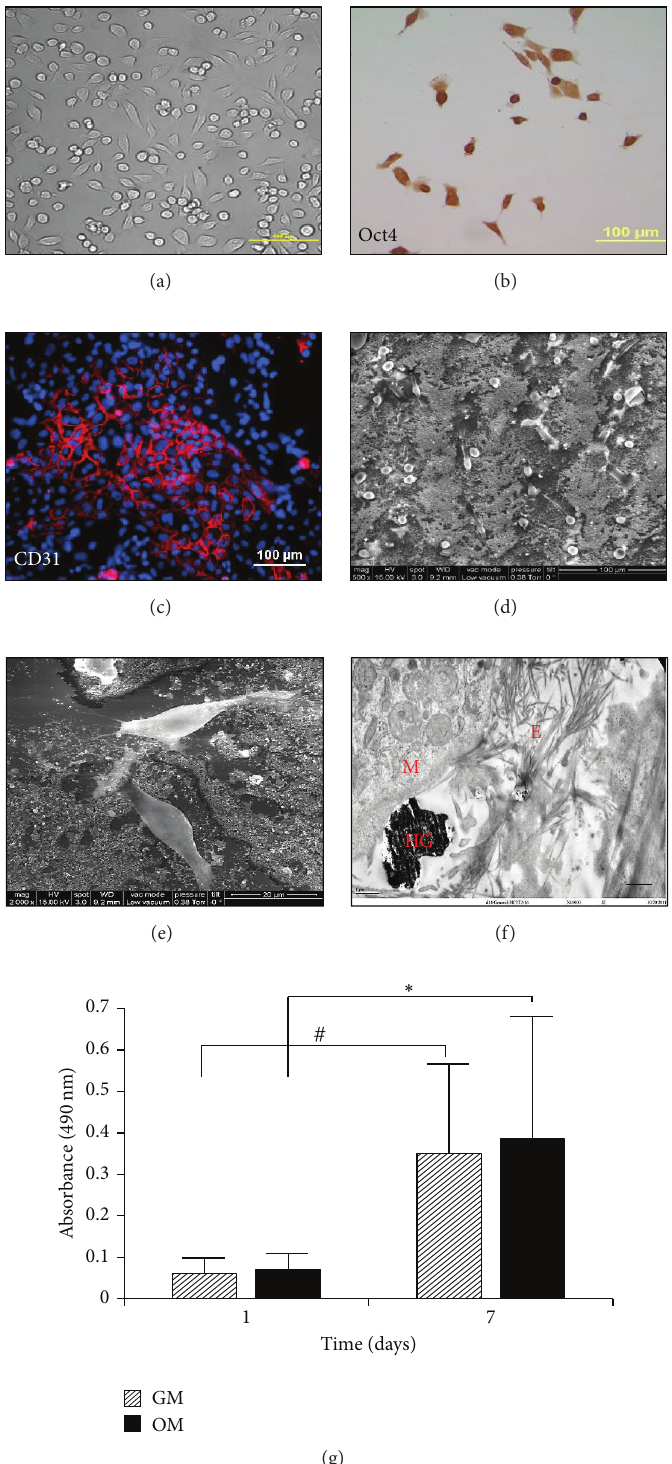
Figure 1: Characterization of rat MAPCs. DIC microscopic picture of MAPCs culture on the fibronectin coated dish (a). MAPCs were stained with Oct4 antibody conjugated with chemiluminescent dye (b) and CD31 antibody conjugated with TRITC (c). SEM analysis visualized MAPCs on the HG materials in low power (d) and high power (e). TEM image of MAPCs that interacted with ECM and HG materials (f): hydroxyapatite (HG), MAPCs (M), and extracellular matrix (E). Scale: 5 𝜇 m. MAPCs proliferation was assessed at baseline (within 24 h after seeding) and after 7 days in osteogenic media; ∗, # 𝑝 < 0.05